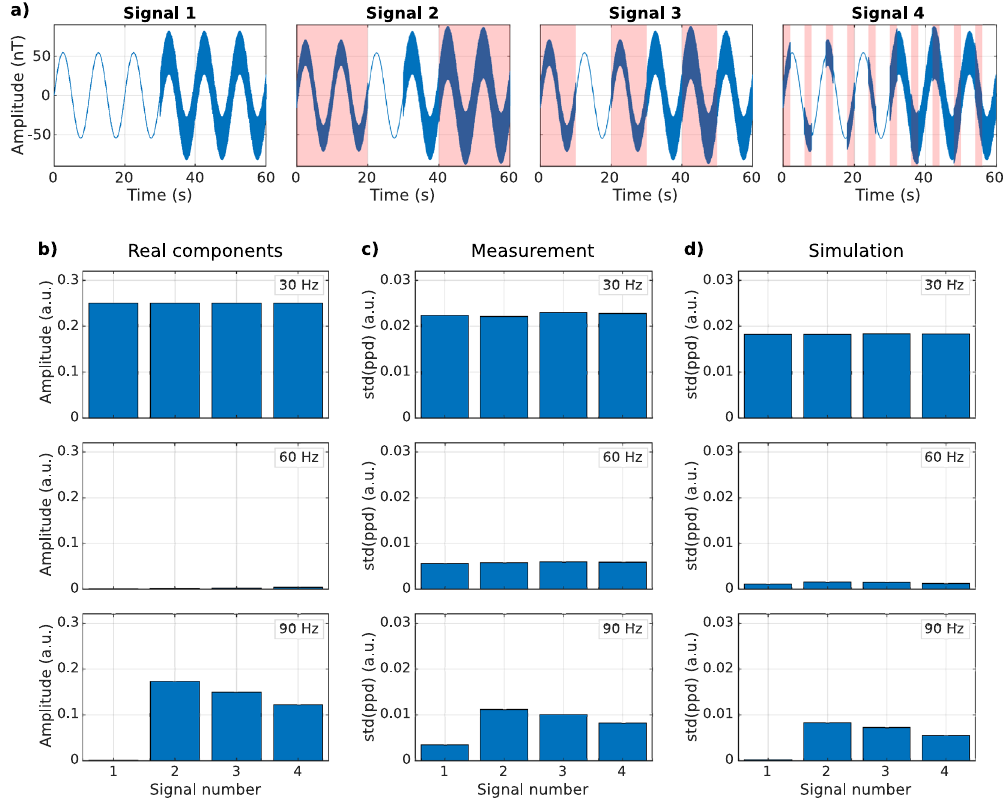
Figure 7. Component reconstruction of individual signals. ( a ) Input signals composed of a 0.1 Hz with a 30 Hz sine the last 30 s. A 90 Hz sine is added in 20, 10, and 2 s blocks for signals 2, 3, and 4 respectively, the shaded areas indicate the location of the 90 Hz wave. ( b ) Frequency components of the signals showed in ( a ) at 30, 60 and 90 Hz. ( c ) Components reconstructed from measurement with F SL fixed at 30, 60 and 90 Hz. ( d ) Frequency components reconstructed from the simulation with the same parameters as in the